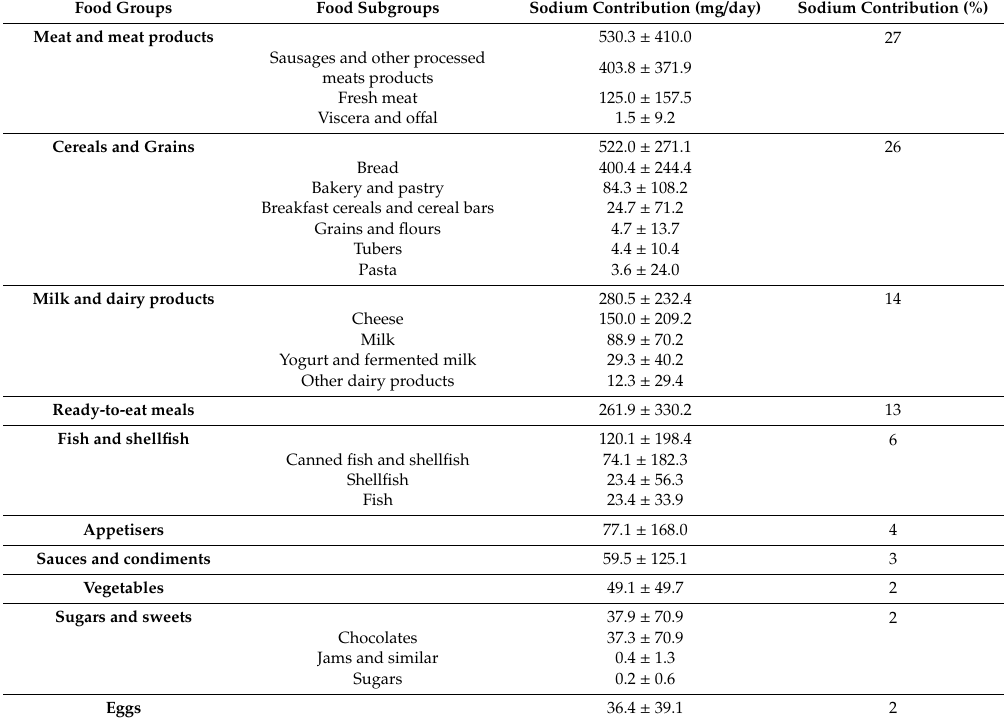
Table 4. Dietary sources of sodium from food groups and subgroups consumed by the ANIBES study population (9–75